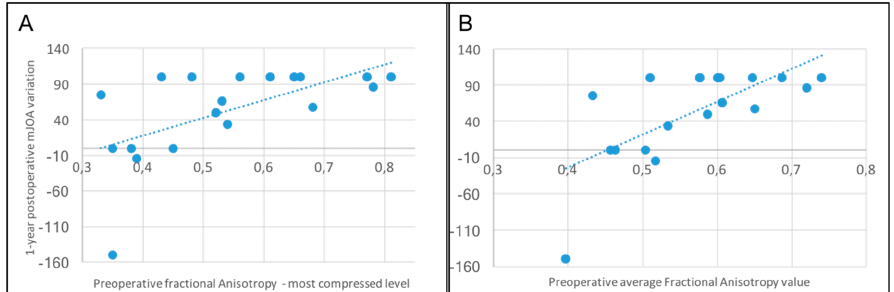
Figure 7. A: Significant correlation between preoperative FA value at the most compressed level and the 1-year postoperative variation of the mJOA ( p = 0.002). B: Significant correlation between preoperative FA average value and the 1-year postoperative variation of the mJOA ( p =